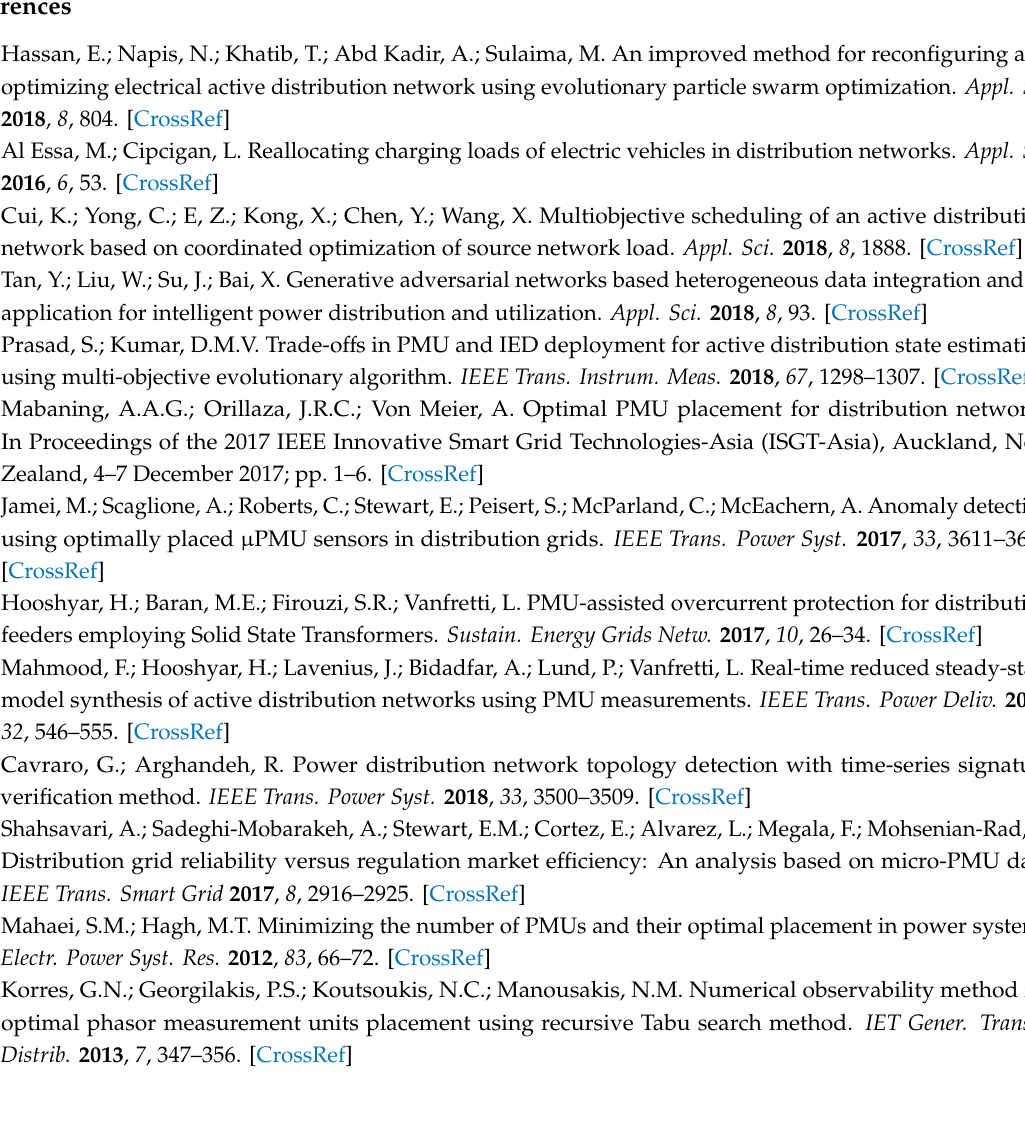
Figure A2. IEEE 69 bus system.